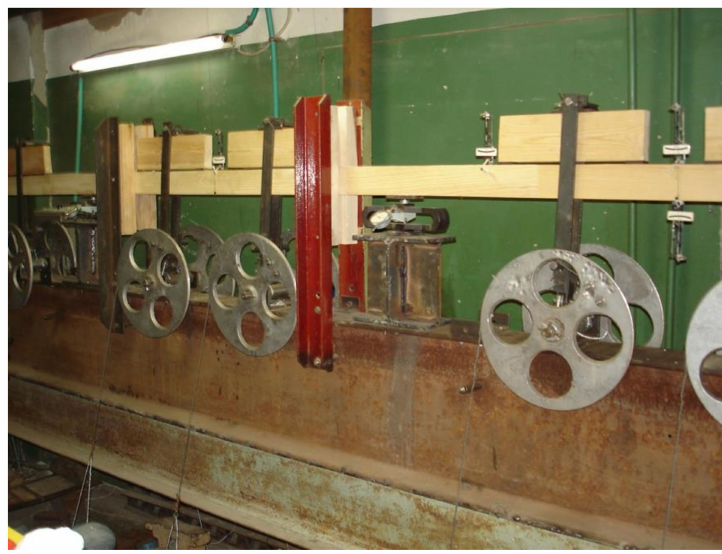
Figure 4. Experimental stand with mounted